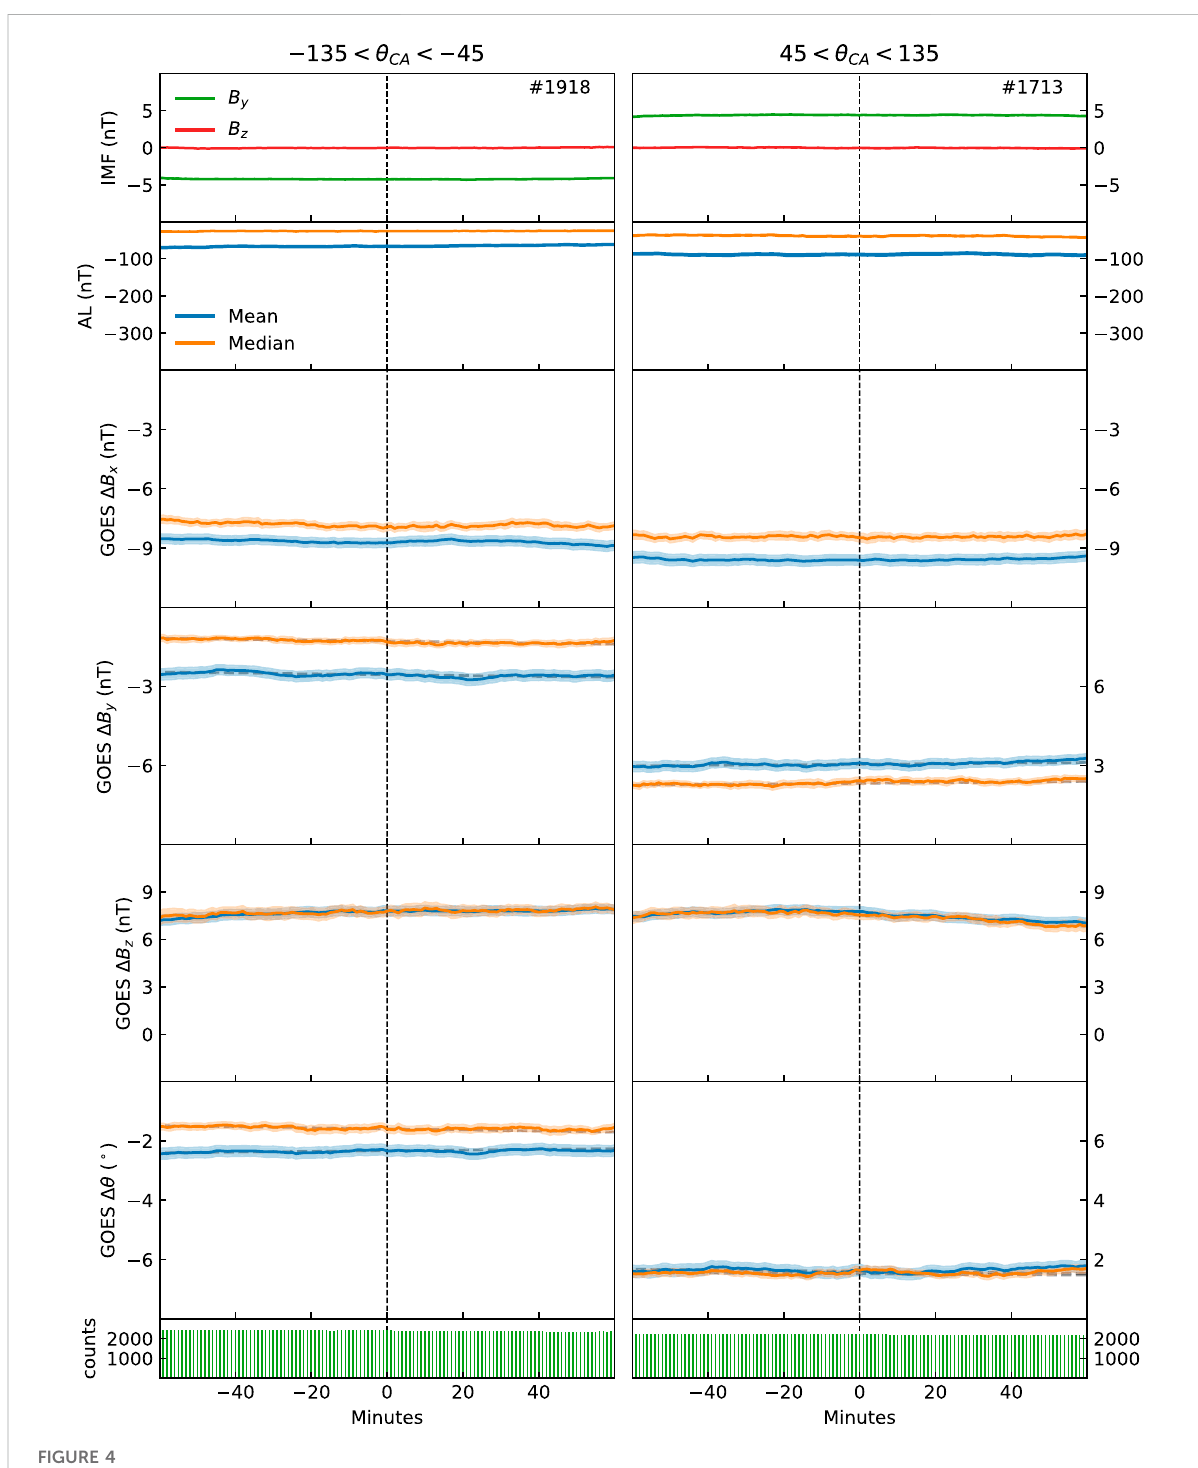
FIGURE 4 Superposed epoch analysis relative to randomly identi fi ed control times, format as Figure